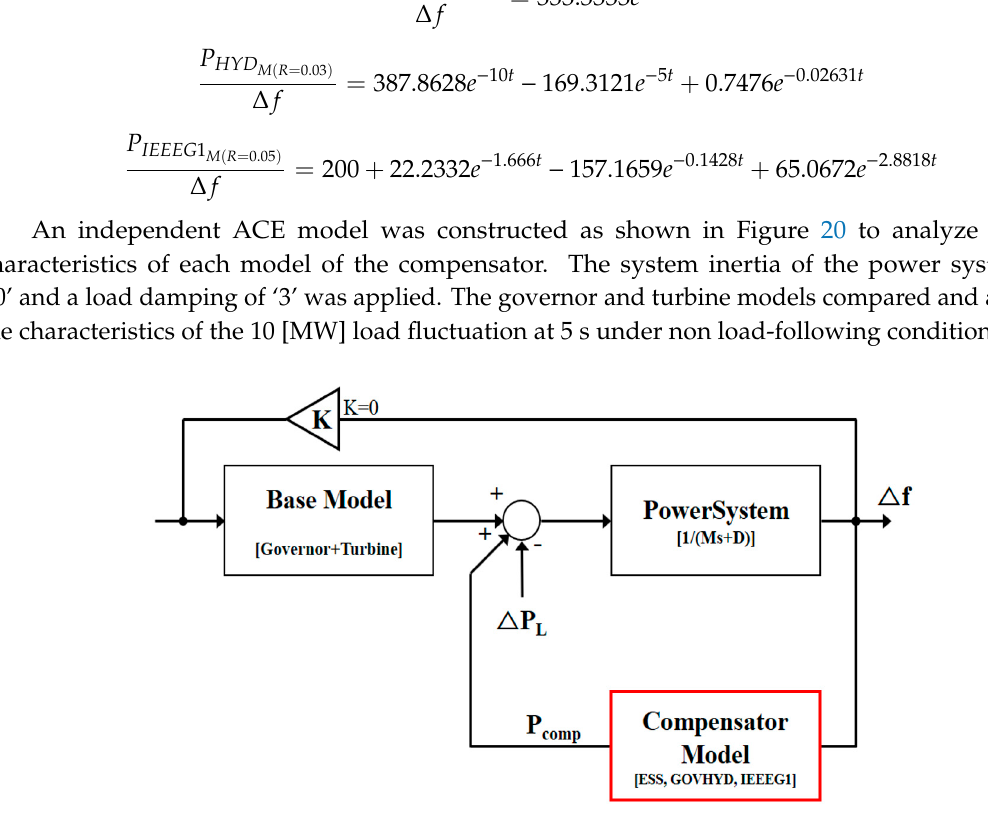
Figure 20. Configuration for simulation of compensation equipment.